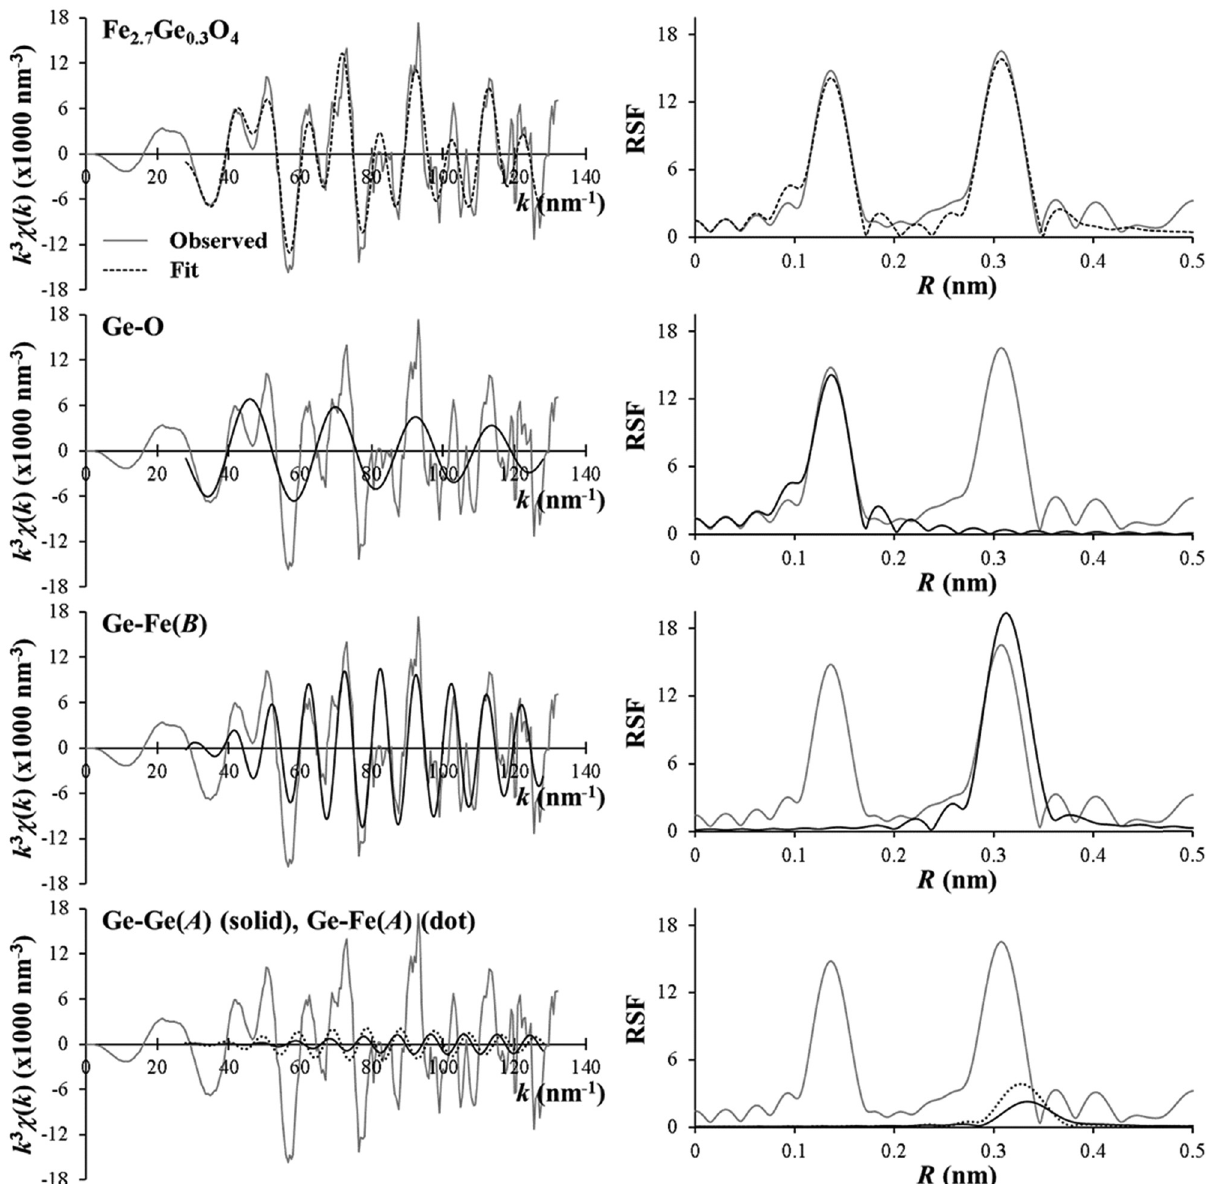
Figure A1: The calculated EXAFS spectrum and RSF for the reference Fe 2.7 Ge 0.3 O 4 based on a structure model that all Ge atoms are considered to distribute the tetrahedral A site. The top two figures show the total spectrum and RSF including the four correlations of Ge occupying the A site. The three paired figures below show each correlation of O, Fe in the B site, and Fe and Ge in the A site around Ge,